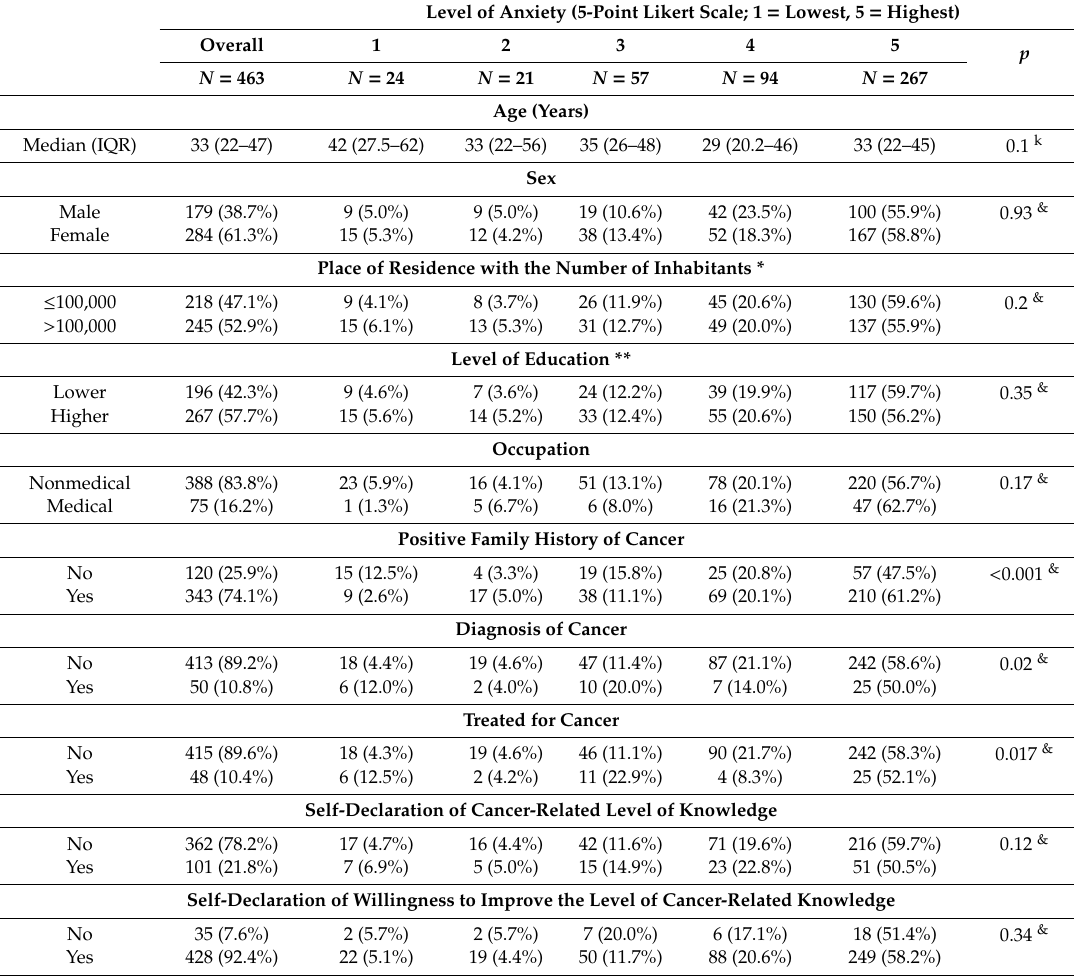
Table 2. The level of cancer-related anxiety delineated by the respondents. Descriptive statistics together with di ff erences tests in subgroups defined by selected